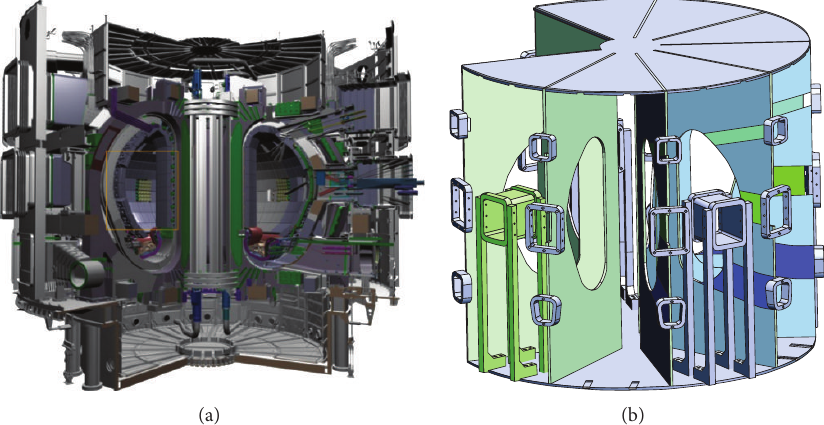
Figure 1: ITER Tokamak [26] and the small-scale Tokamak mockup.